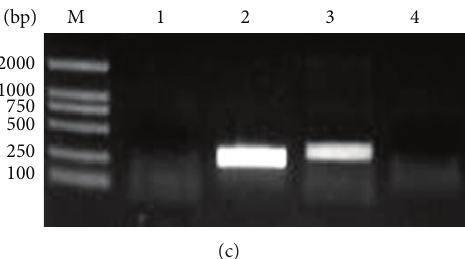
Figure 4: TGF- 𝛽 1 gene in Sj was cloned and identified. (a) TGF- 𝛽 1 mature peptide cDNA in Sj was amplified using Sj adult worm cDNA collected from infected mice as template and primers designed according to mouse TGF- 𝛽 1 mature peptide sequence, and the 5 󸀠 and 3 󸀠 ends of TGF- 𝛽 1 in Sj were extended via RACE. The alignment of TGF- 𝛽 1 cDNA sequences of Sj and mouse is shown (Query is Sj TGF- 𝛽 1 and Sbjct. is mouse TGF- 𝛽 1 cDNA sequence). Solid lines: specific mouse TGF- 𝛽 1 primer pairs for PCR amplification; dotted lines: specific Sj TGF- 𝛽 1 primer pairs for PCR amplification. Gray: TGF- 𝛽 1 mature peptide cDNA sequence. (b) The alignment of TGF- 𝛽 1 amino acid sequences of Sj and mouse is shown (Query is Sj TGF- 𝛽 1 and Sbjct. is mouse TGF- 𝛽 1 amino acid sequence). Gray: TGF- 𝛽 1 mature peptide amino acid sequence. (c) TGF- 𝛽 1 primers of mouse- or Sj -specific source were identified through PCR using Sj adult worms or normal mice liver cDNA as template, respectively. M: DL2000 DNA Marker; 1: mouse cDNA as template and specific Sj TGF- 𝛽 1 primer; 2: mouse cDNA as template and specific mouse TGF- 𝛽 1 primer; 3: Sj cDNA as template and specific Sj TGF- 𝛽 1 primer; 4: Sj cDNA as template and specific mouse TGF- 𝛽 1